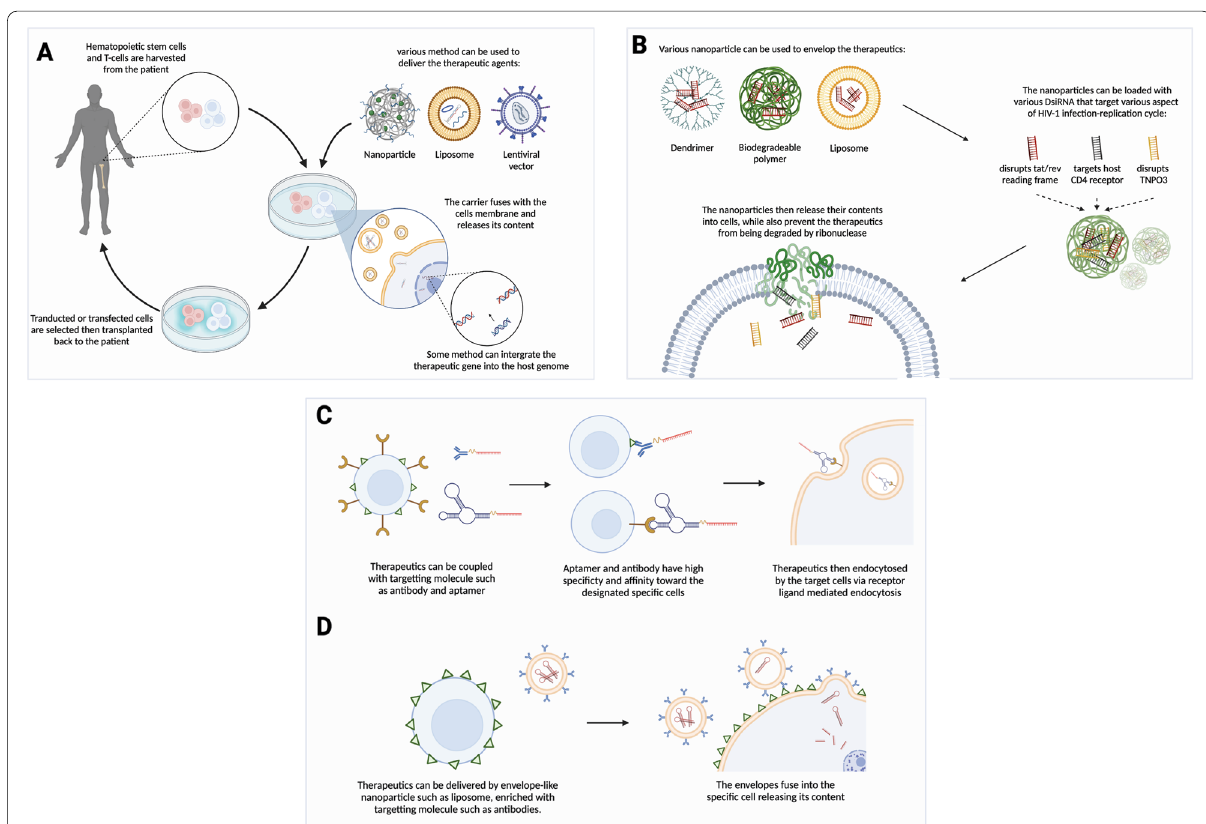
Fig. 5 Possible methods of multiplexed shRNA-miRs delivery. A Ex vivo administration of therapeutics can be done on the patient’s stem cells or T cell transplants. The cells are harvested from the patient’s tissue into a culture vessel, then subjected to transfection by using liposomes or nanoparticles; or transduction by using viral vectors such as adenoviral vectors or lentiviral vectors. Lentiviral vectors can integrate the therapeutic gene into the host genome. B Non-specific in vivo administration can utilize dendrimers, polymers, and liposomes to encapsulate the therapeutics. Various DsiRNA can also be added into the construct along with the CCR5 knockout siRNA. As the nanoparticles attach to cells, they can fuse with the cell membrane and release their content into the cell. C Therapeutics can be coupled with antibodies or aptamers to target specific cells. The therapeutics can latch to the cell receptor and enter the cell by receptor-ligand mediated endocytosis. D Envelope-type nanoparticles such as liposomes, dendrimers, and polymers can be enriched with targeting molecules to convey the siRNA to specific cells. The nanoparticles then can fuse with the cell membrane and deliver therapeutics while also preventing the siRNA degradation by